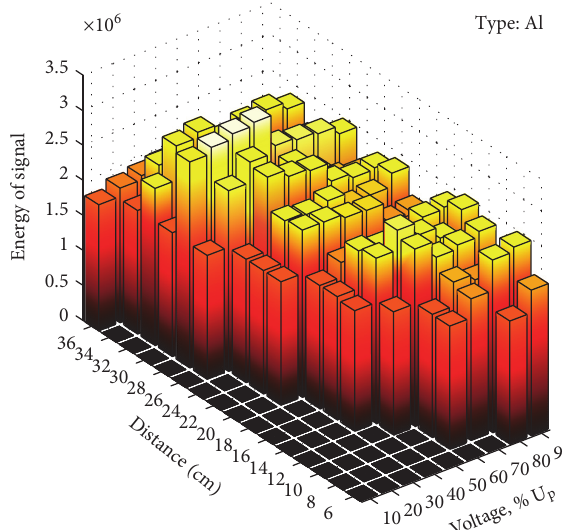
Figure 6: Dependency of voltage and distance on the value of energy of signal calculated for optical spectra emitted by corona around the AlSi5 line.